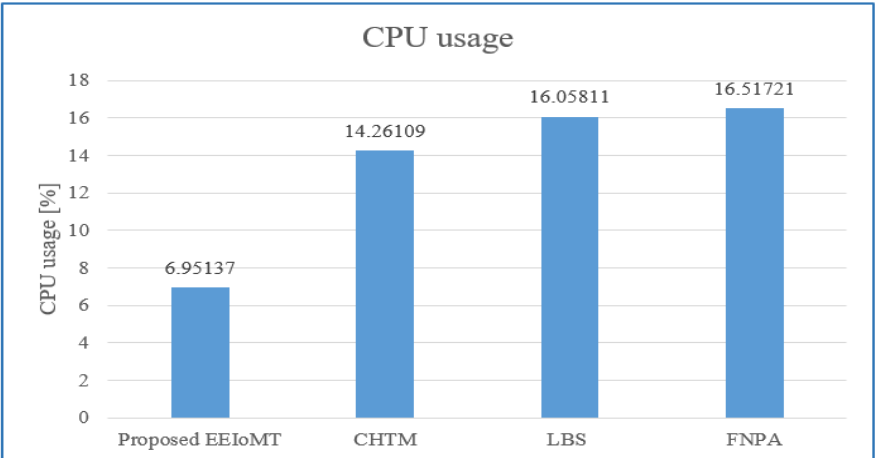
Figure 7. Comparison of CPU usage.